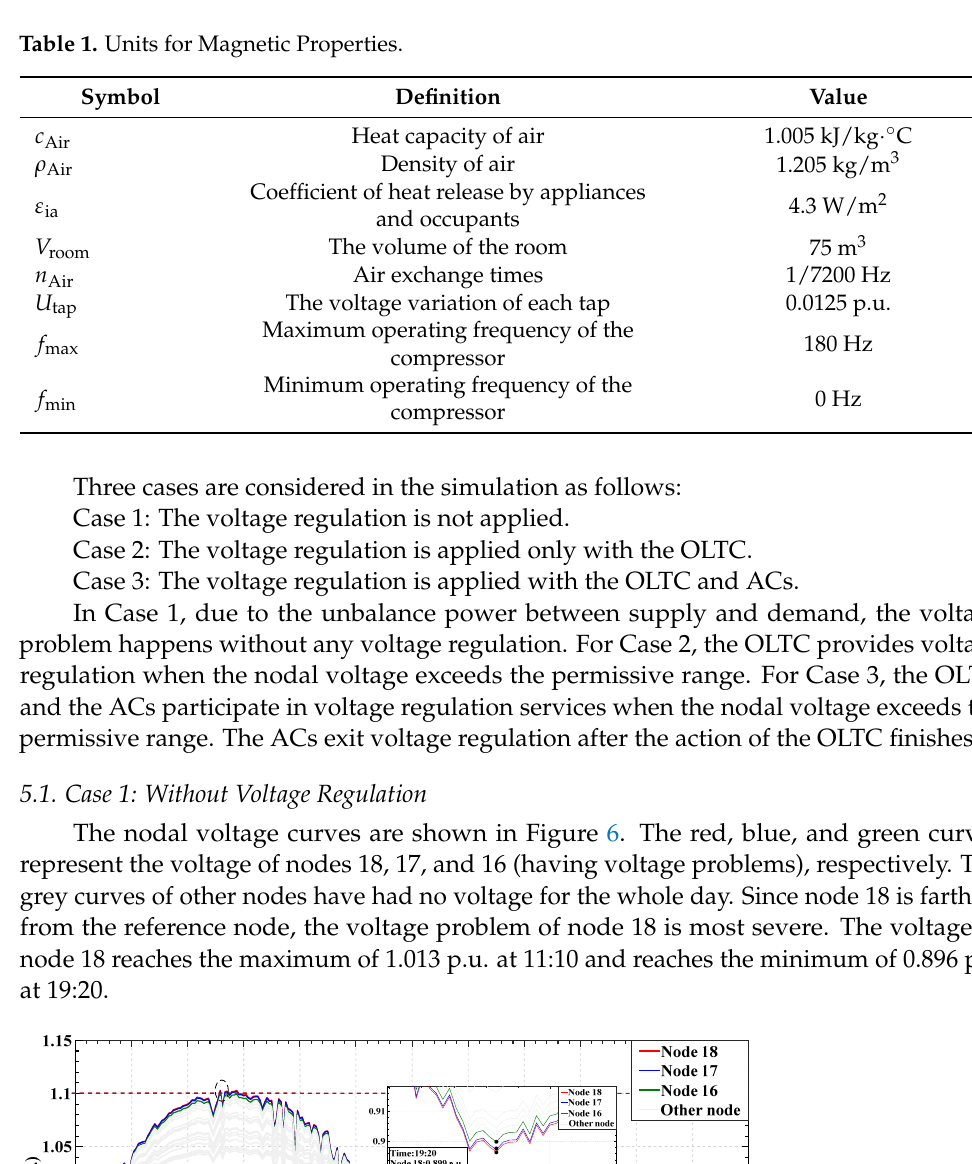
1.051.11.15 Figure 7. The voltages curves after regulation by the OLTC. 5.3. Case 3: Voltage Regulation with OLTC and ACs To solve the delay problem of the OLTC, the ACs will provide voltage regulation services during the delay time. At 11:10, the distribution network encounters the over- voltage problem. The ACs and the OLTC both participate in voltage regulation. The ACs in node 18 increase 58.46 kW operating power for over-voltage regulation. The four groups of the ACs increase 0 kW (Group 1: 0 ACs), 26.31 kW (Group 2: 50 ACs), 29.57 kW (Group 3: 47 ACs) and 2.58 kW (Group 4: 3 ACs) of operating power, respectively. The voltage of node 18 decreases to 1.099 p.u. After 1 min, the action of the OLTC finishes, the ACs exit voltage regulation, and the voltage of node 18 decease to 1.091 p.u. At 18:40, the distribution network encounters the under-voltage problem. The ACs and the OLTC both participate in voltage regulation. The ACs in node 18 decrease 37.31 kW operating power for under-voltage regulation. The four groups of the ACs decrease 0 kW (Group 1: 0 ACs), 0.24 kW (Group 2: 5 ACs), 13.81 kW (Group 3: 49 ACs) and 23.26 kW (Group 4: 46 ACs) of operating power, respectively. The voltage of node 18 increases to 0.900 p.u. After 1 min, the action of the OLTC finishes, and when the ACs exit voltage regulation, the volt- age of node 18 increases to 0.911 p.u.. The nodal voltage curves are shown in Figure 8. 6:00 8:00 10:00 12:00 14:00 16:00 18:00 20:00 22:00 0:00 2:00 4:00 6:00 Time0.850.90.95 1